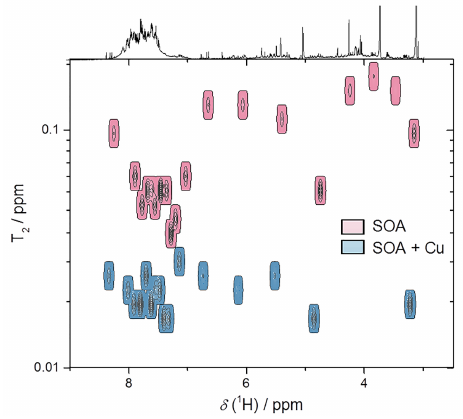
Figure 9. 2-D 1 H-NMR T2 relaxation contour map for NSOA with (blue) and without copper (red) with 1-D NMR projections from the top. A general decreasing trend in T2 is observed here, which indicates interactions (binding) of Cu (II) with many NSOA com-